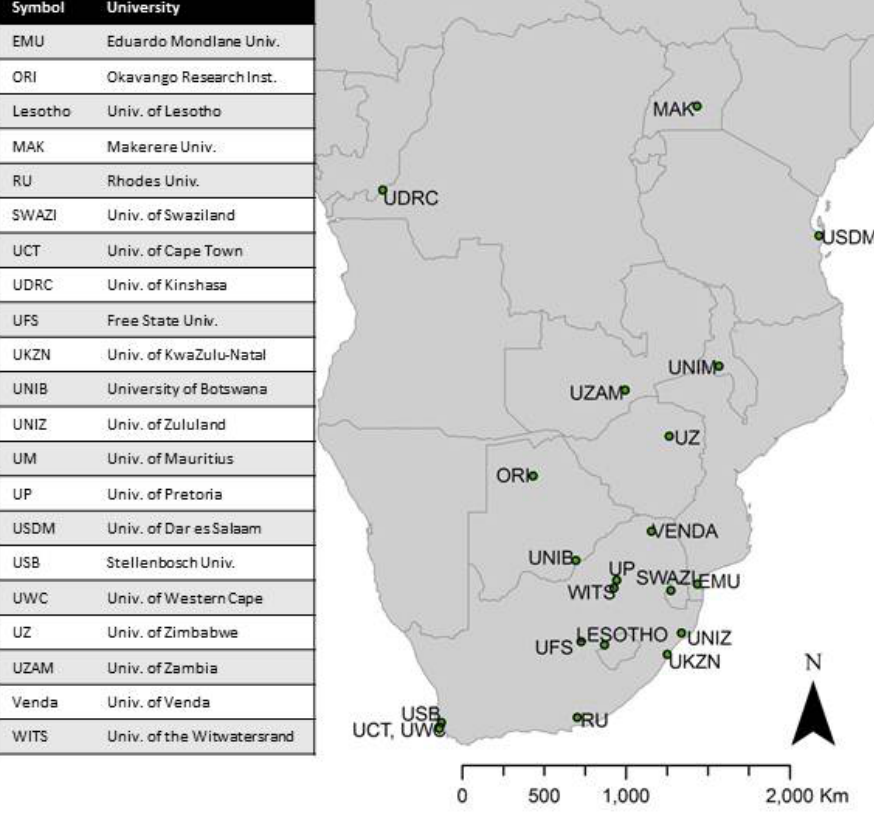
Fig. 1. Universities within continental southern Africa with some involvement in hydrological training and research (Univ. of Mauritius is not